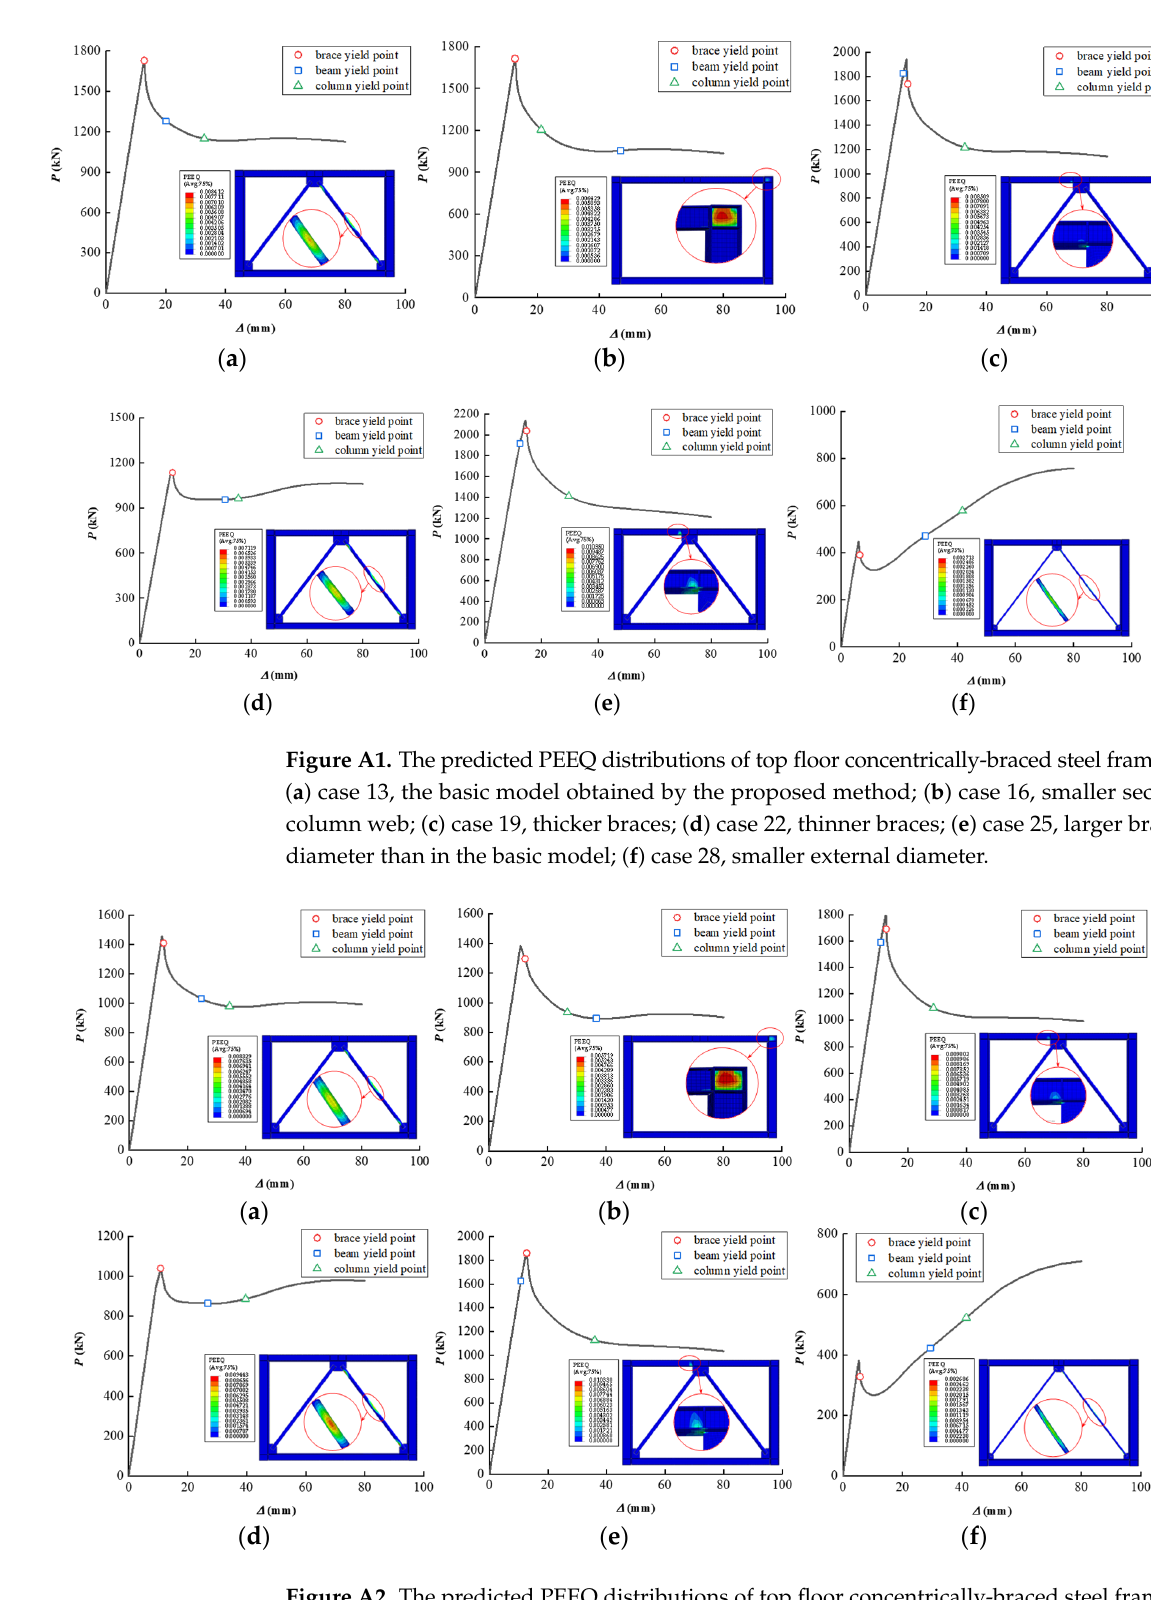
Figure A2. The predicted PEEQ distributions of top floor concentrically-braced steel frames ( η = 0.2). ( a ) case 14, the basic model obtained by the proposed method; ( b ) case 17, smaller section area of column web; ( c ) case 20, thicker braces; ( d ) case 23, thinner braces; ( e ) case 26, larger brace external diameter than in the basic model; ( f ) case 29, smaller external diameter.